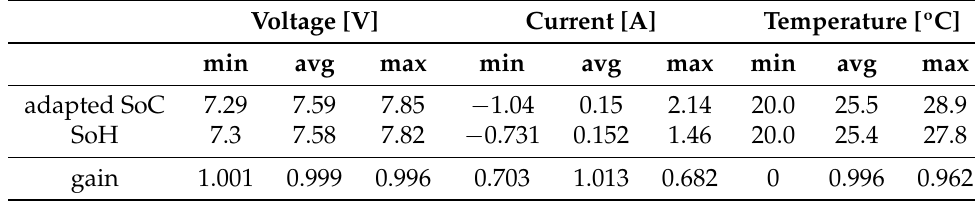
Table 16. Battery 2 during a month of simulation: Case 3.